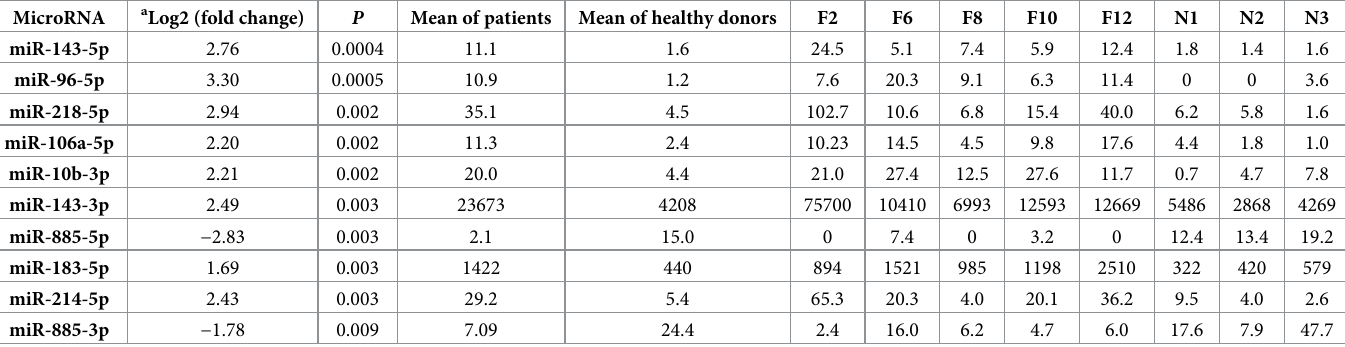
Table 2. Candidate microRNAs detected by next-generation sequencing and results of Trimmed Mean of M-values (TMM) in samples.